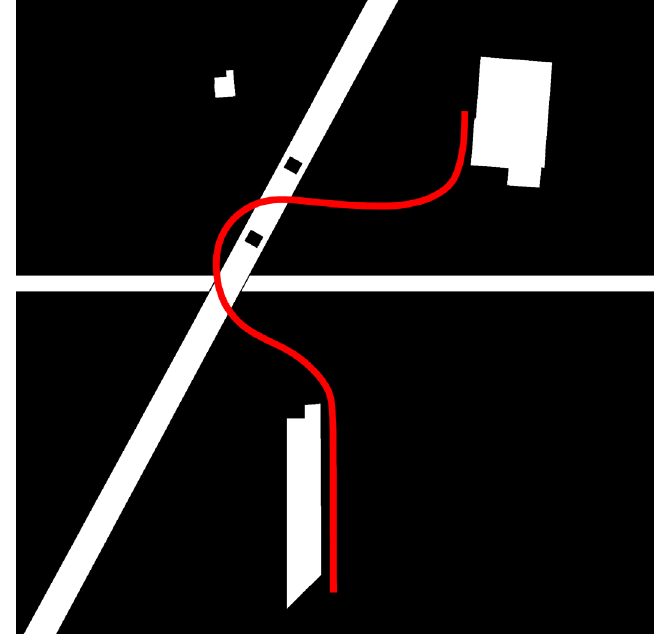
Fig. 2 Belardi, P., Battistoni, M., & Sorignani, C., Hortus line project (Perugia), concept,